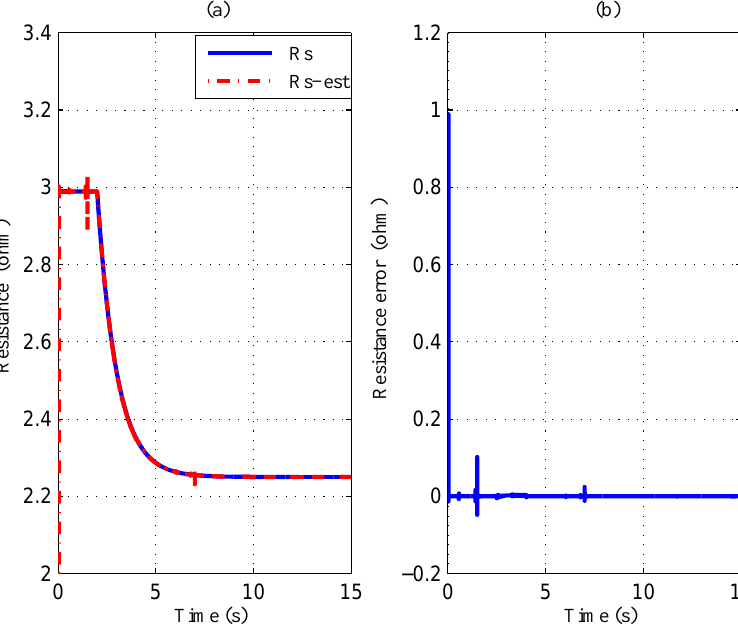
Figure 8. Robustness w.r.t. − 30% R s : ( a ) estimated and real resistance; and ( b ) estimation